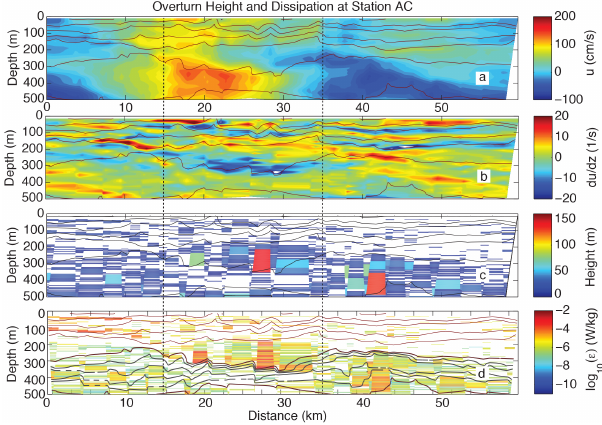
Figure 11. The zonal velocity (a) and vertical shear (b) repre- sented in color plotted with density (solid black lines) as a func- tion of pseudo-distance for anchor station AC. The x axis was con- verted from time to distance using the observed propagation speed (0.67ms − 1 ) of the mode-2 wave (Table 1). The bottom two panels are the overturn heights (c) and turbulent dissipation (d) determined via Thorpe scaling. The density contour intervals on the bottom plot represent 1.0 sigma-T units (red) and 0.5 sigma-T units (gray). The dotted vertical lines indicate the horizontal bounds of the mode-2 wave used in the energy and flux